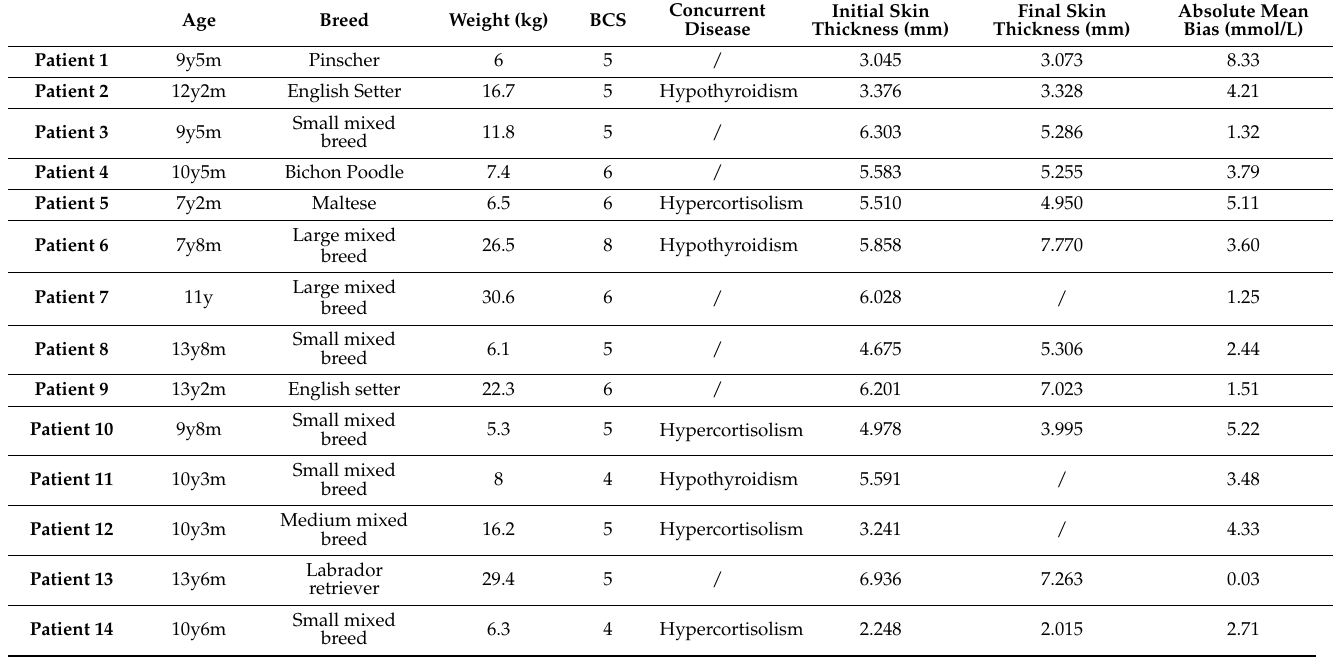
Table 1. Clinical data, skin thickness and absolute mean bias of each